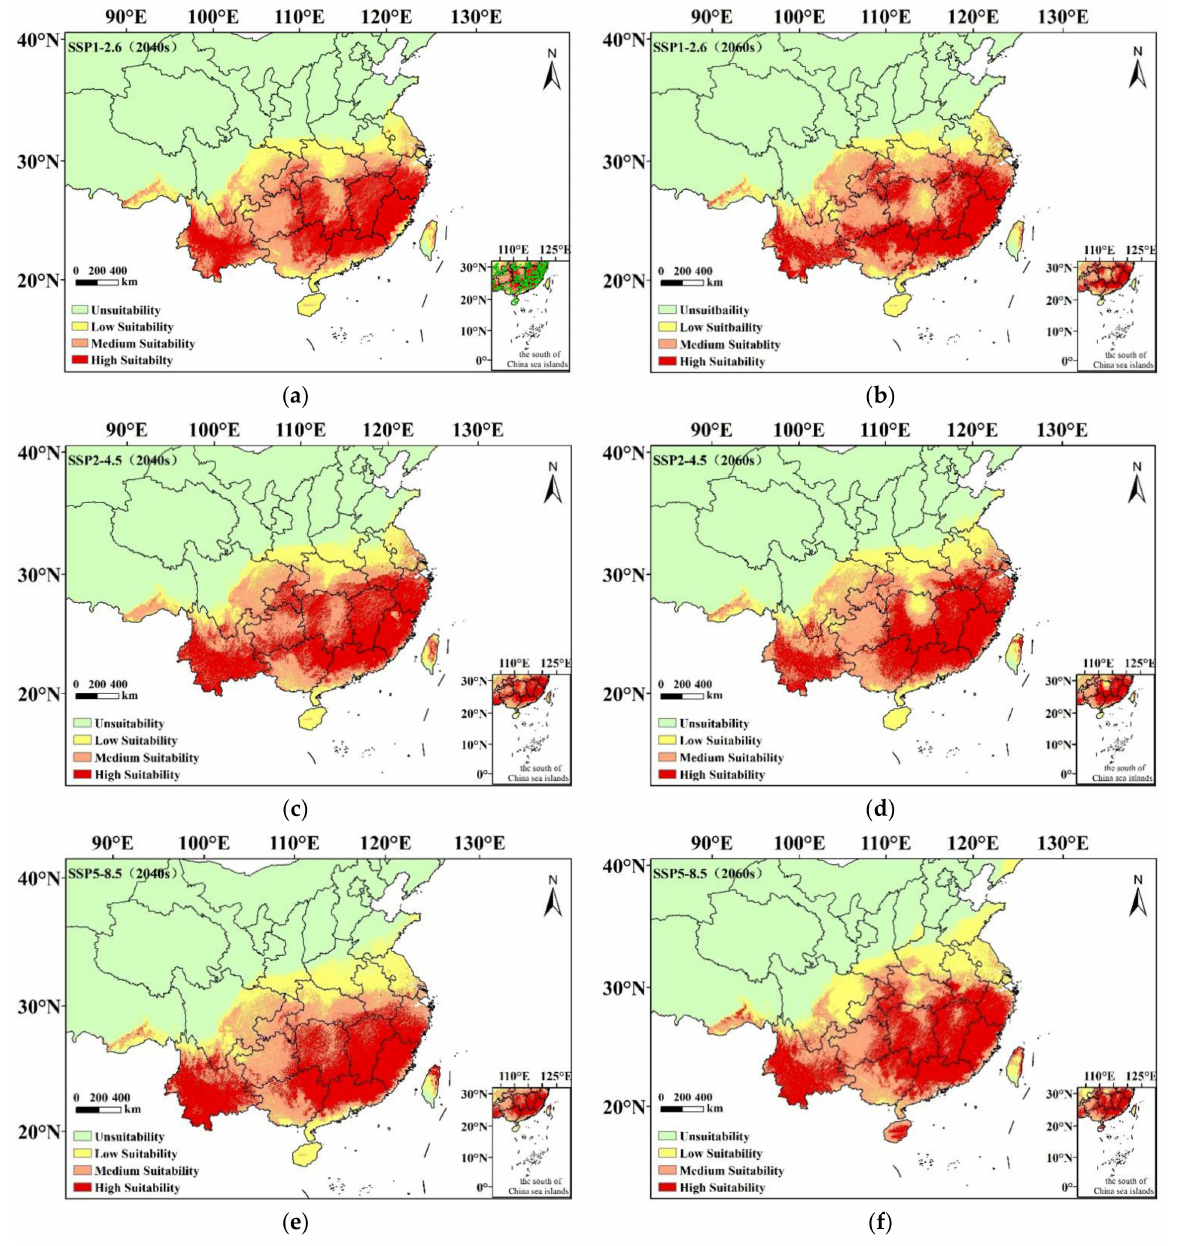
Figure 4. Potentially suitable cultivations regions of C. hystrix Miq. in China under future climatic conditions: ( a ). ssp1-2.6 (2040); ( b ). ssp1-1.6 (2040); ( c ). ssp2-4.5 (2040); ( d ). ssp2-4.5 (2060); ( e ). ssp5- 8.5 (2040); ( f ). ssp5-8.5